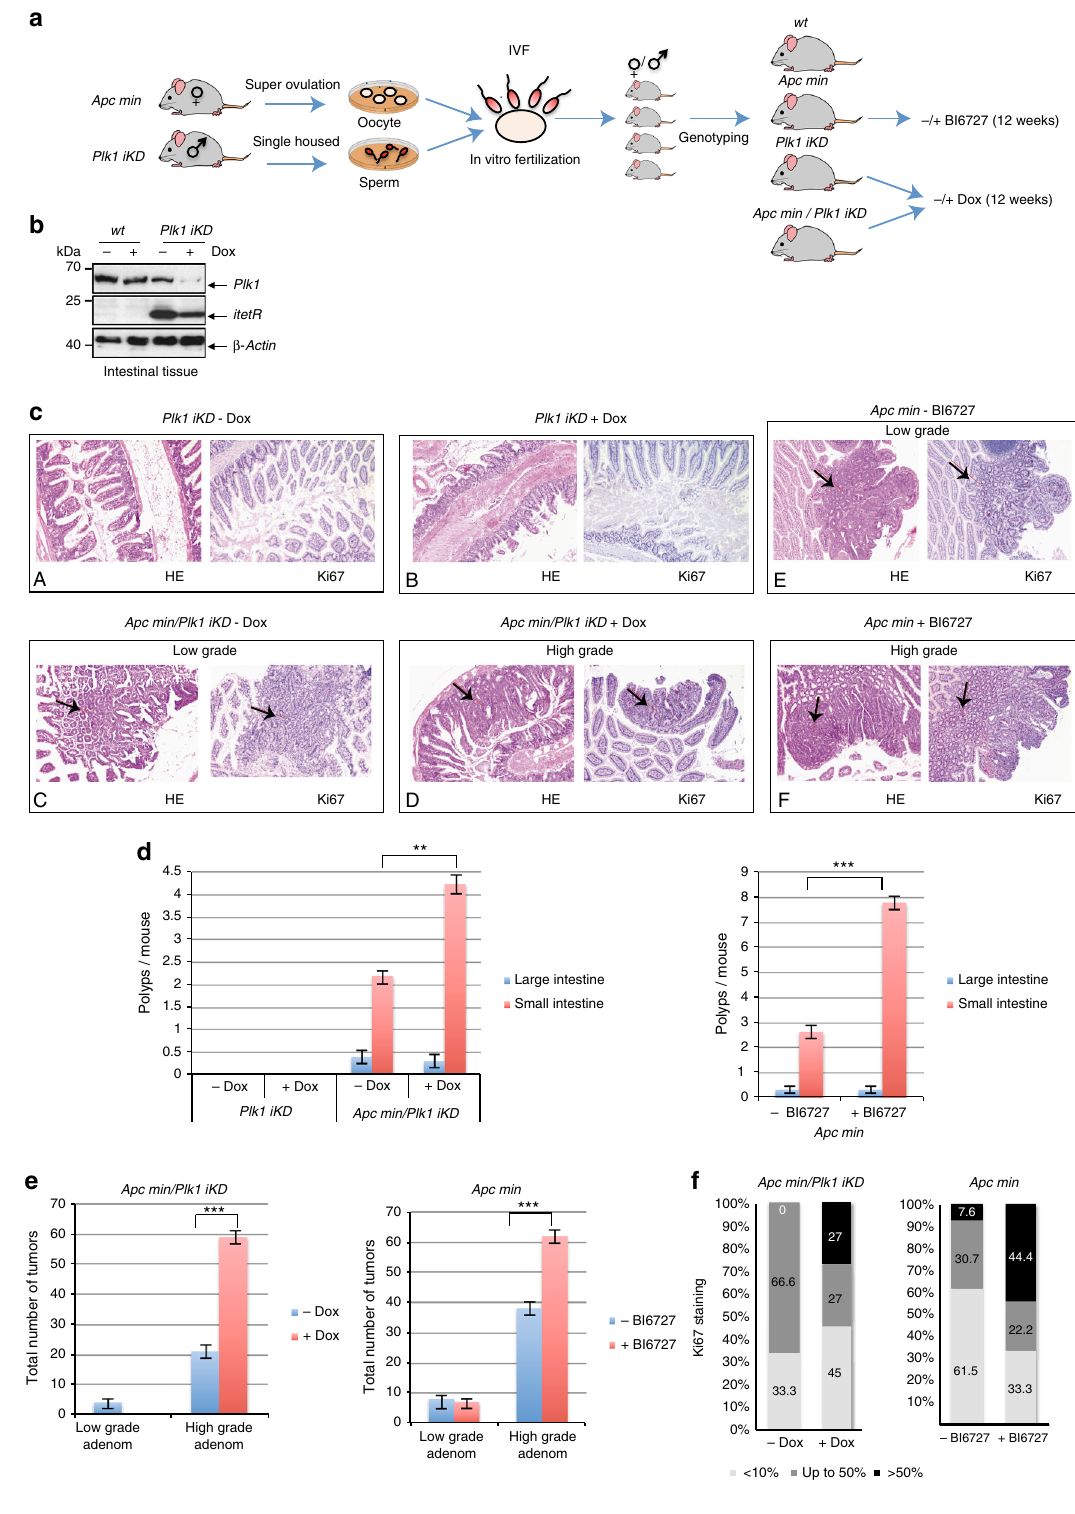
C57BL/6;129S6-Gt(ROSA)26Sortm1226(RNAi:PLK1) ArteN3 Plk1 iKD males. A cohort of 153 offspring was analyzed by genotyping. The frequency of newborn mice heterozygous for both Apc Min/ + and Plk1 iKD was 21.0% (32/153), which is close to blasts (MEF) clones representing different genotypes ( Apc Min/ + , the percentage predicated by Mendelian ’ s law of segregation. Plk1 iKD , Apc Min/ + Plk1 iKD , wt) by PCR and Western blotting (Supplementary Fig. 10a). The Dox concentration (0 – 100 μ g ml − 1) and the Plk1 protein levels were inversely